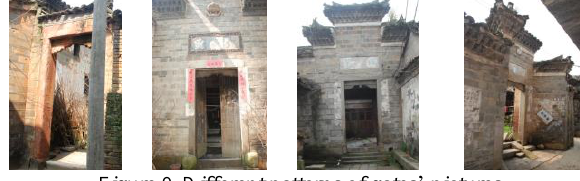
Figure 9. Different patterns of gates’